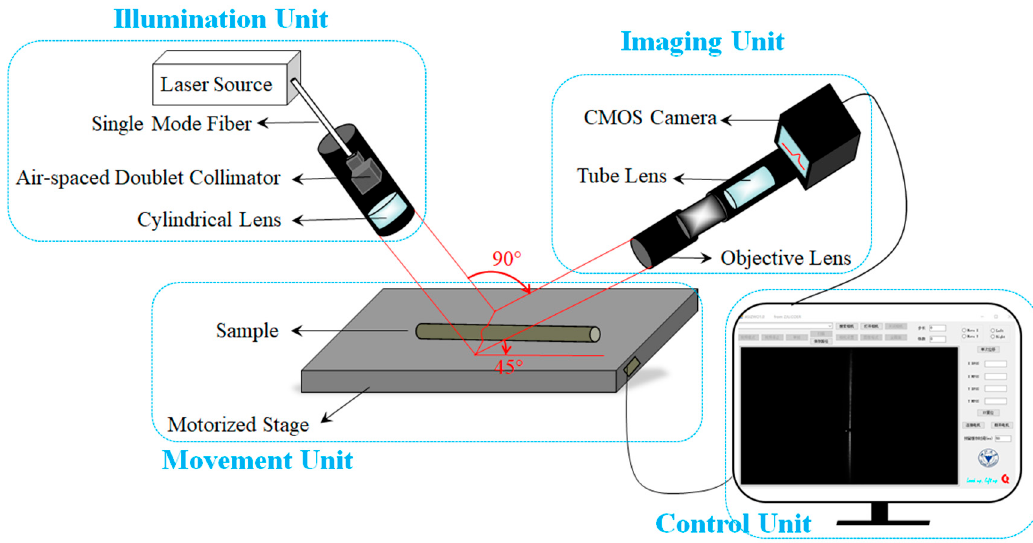
Figure 1. Schematic diagram of the light-sheet microscopy (LSM) system, which consists of four parts: an illumination unit, an imaging unit, a movement unit and a control unit, the details of which are described in Section 2.